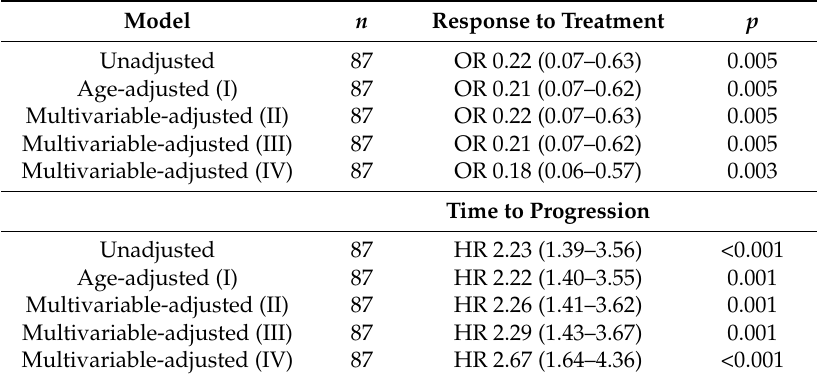
Figure 1. Kaplan-Meier estimates of time to biochemical progression on abiraterone acetate and prednisone stratified by rs2486758 genotype (hetero- and minor homozygotes versus major homozygotes). Table 3. Multivariable-adjusted effect estimates for rs2486758 and biochemical response to abiraterone acetate and prednisone as well as time to biochemical progression in 87 patients with metastatic castration-resistant prostate cancer.